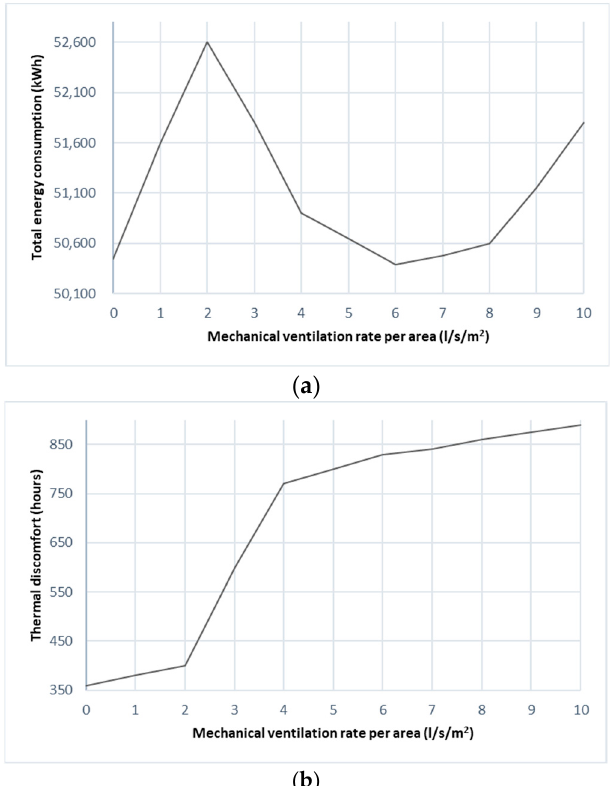
Figure 14. The effect of mechanical ventilation rate per area on ( a ) energy consumption and ( b ) students’ thermal discomfort